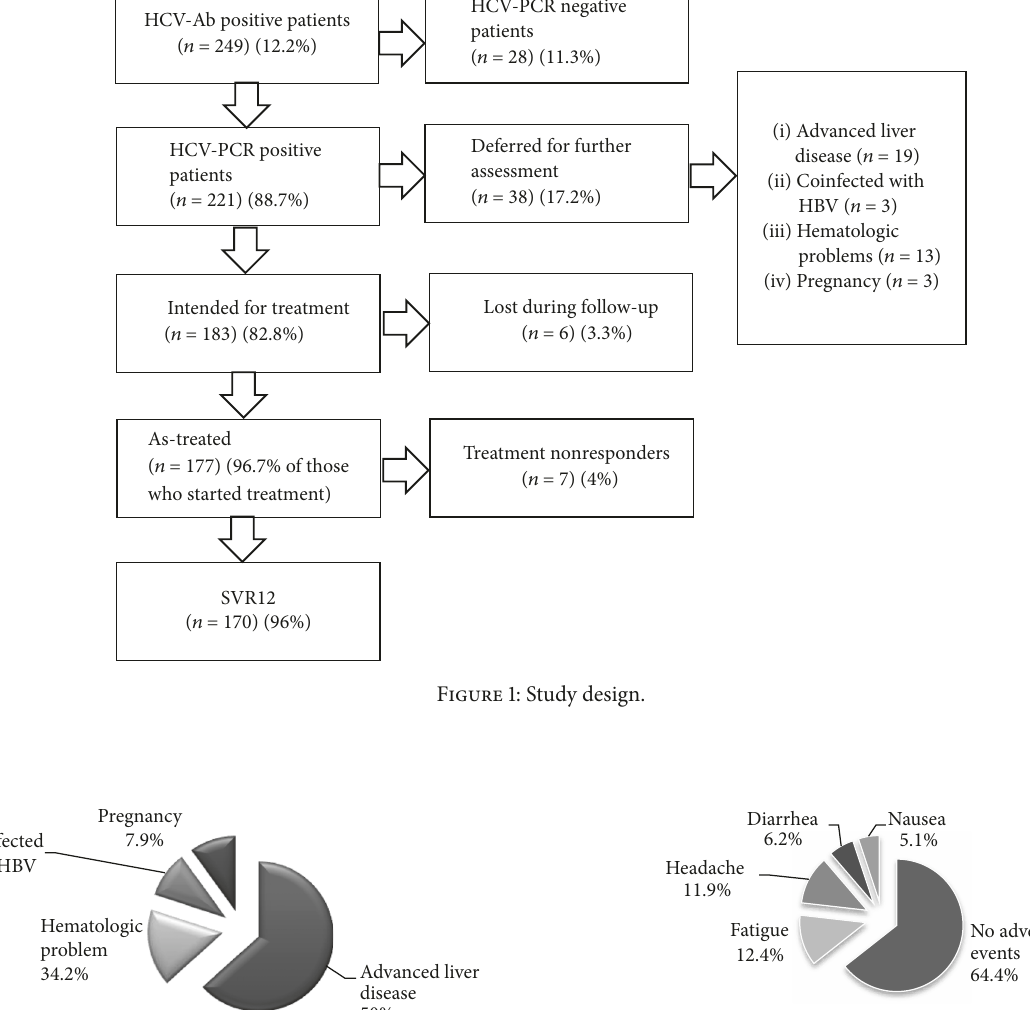
patients were males (42.4%) and 102 patients were females (57.6%) (Figures 1 and 2).